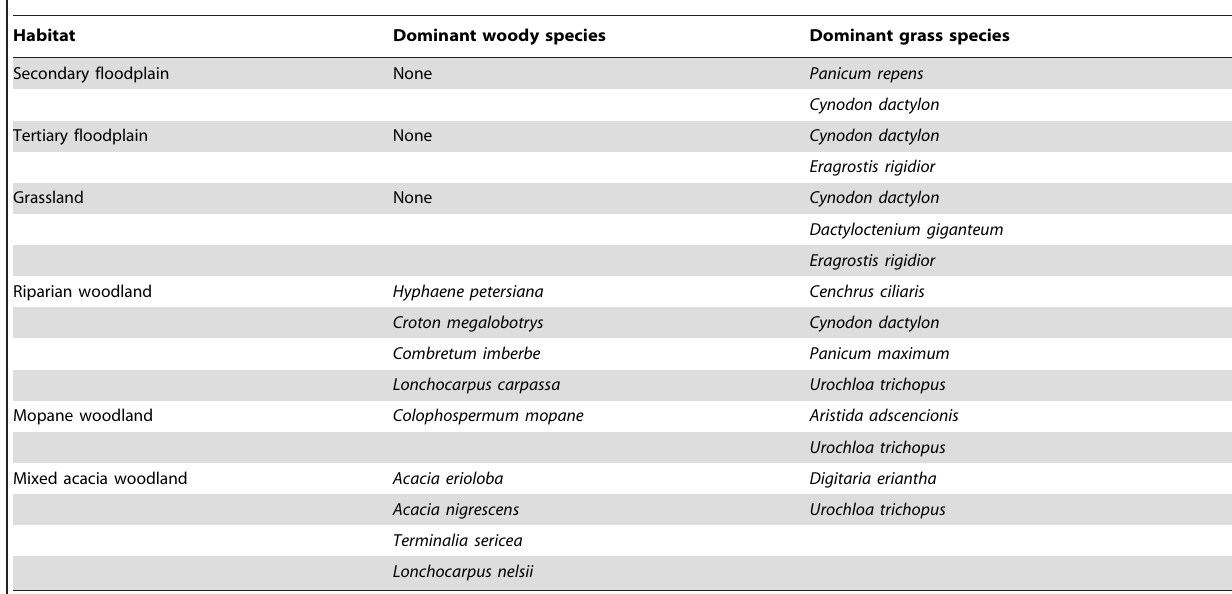
Table 1. Dominant species in the six habitat types found in study